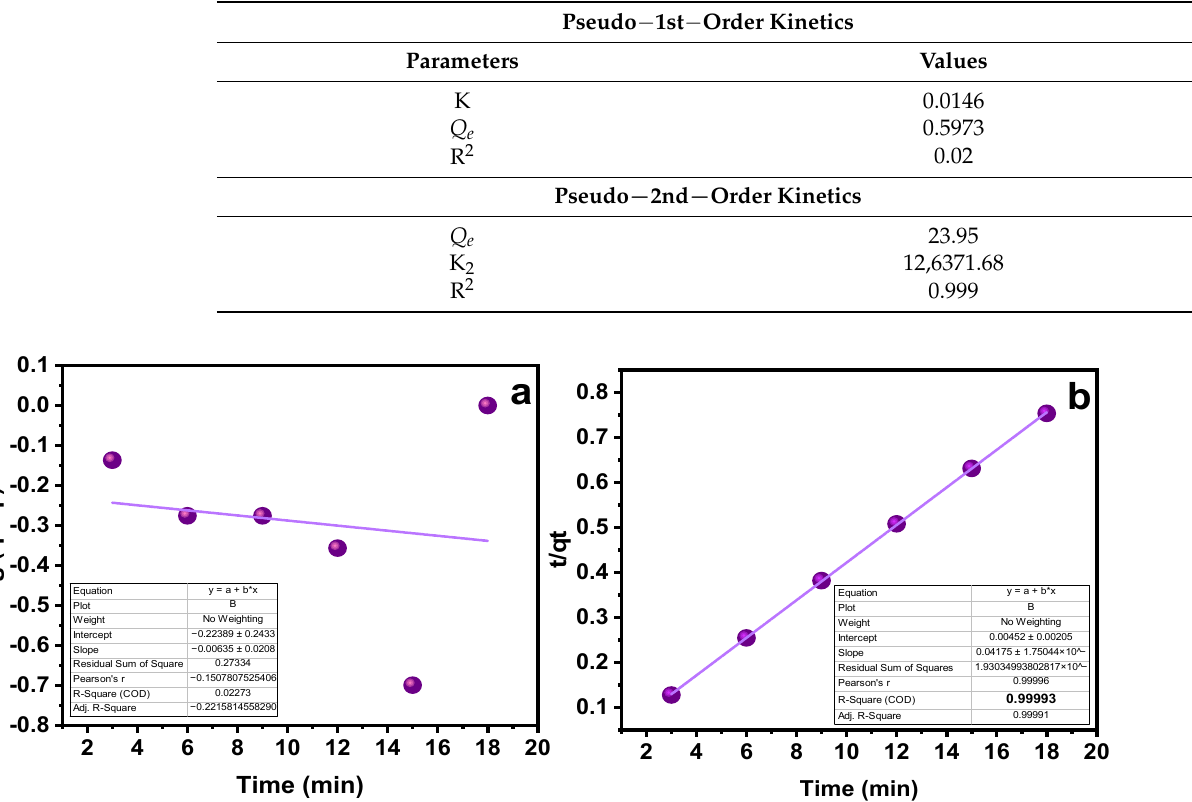
Figure 6. Kinetic studies ( a ) Pseudo − 1st − order kinetics ( b ) Pseudo − 2nd − order kinetics. Table 1. Kinetic Parameters for Pseudo − 1st − order kinetics and Pseudo − 2nd − order kinetics.